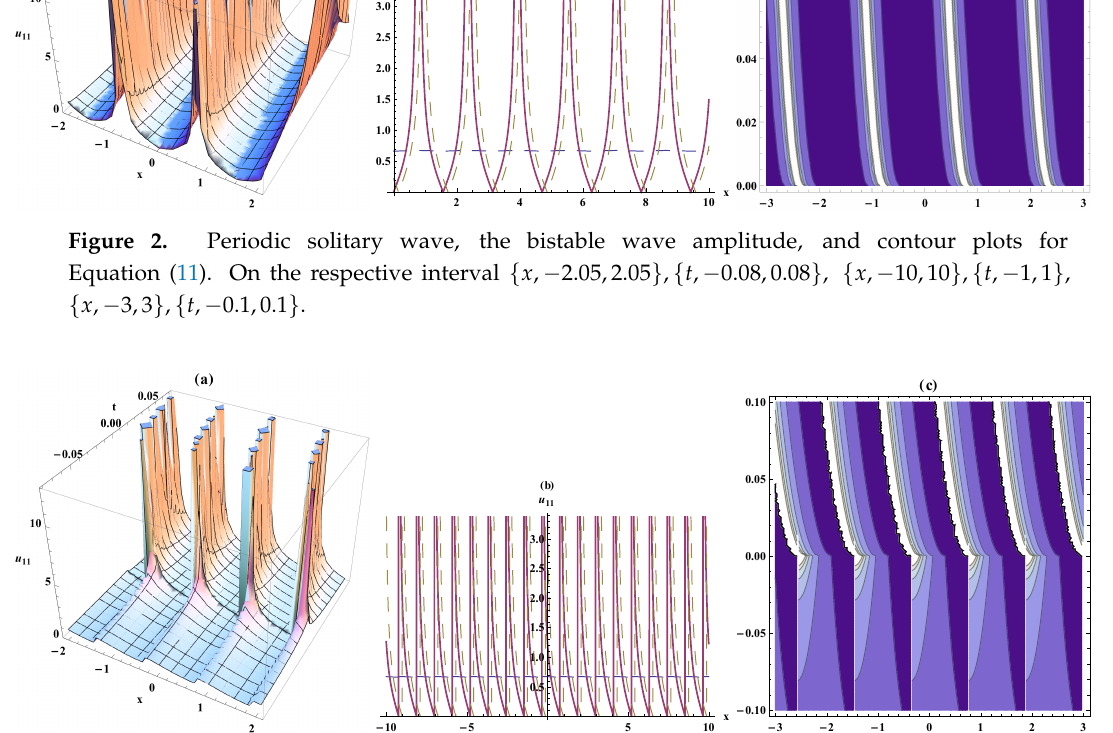
Figure 3. Periodic solitary wave, the bistable wave amplitude, and contour plots for Equation (16). On the respective interval { x , − 2.05,2.05 } , { t , − 0.08,0.08 } , { x , − 10,10 } , { t , − 1,1 } , { x , − 3,3 } , { t , − 0.1,0.1 } .